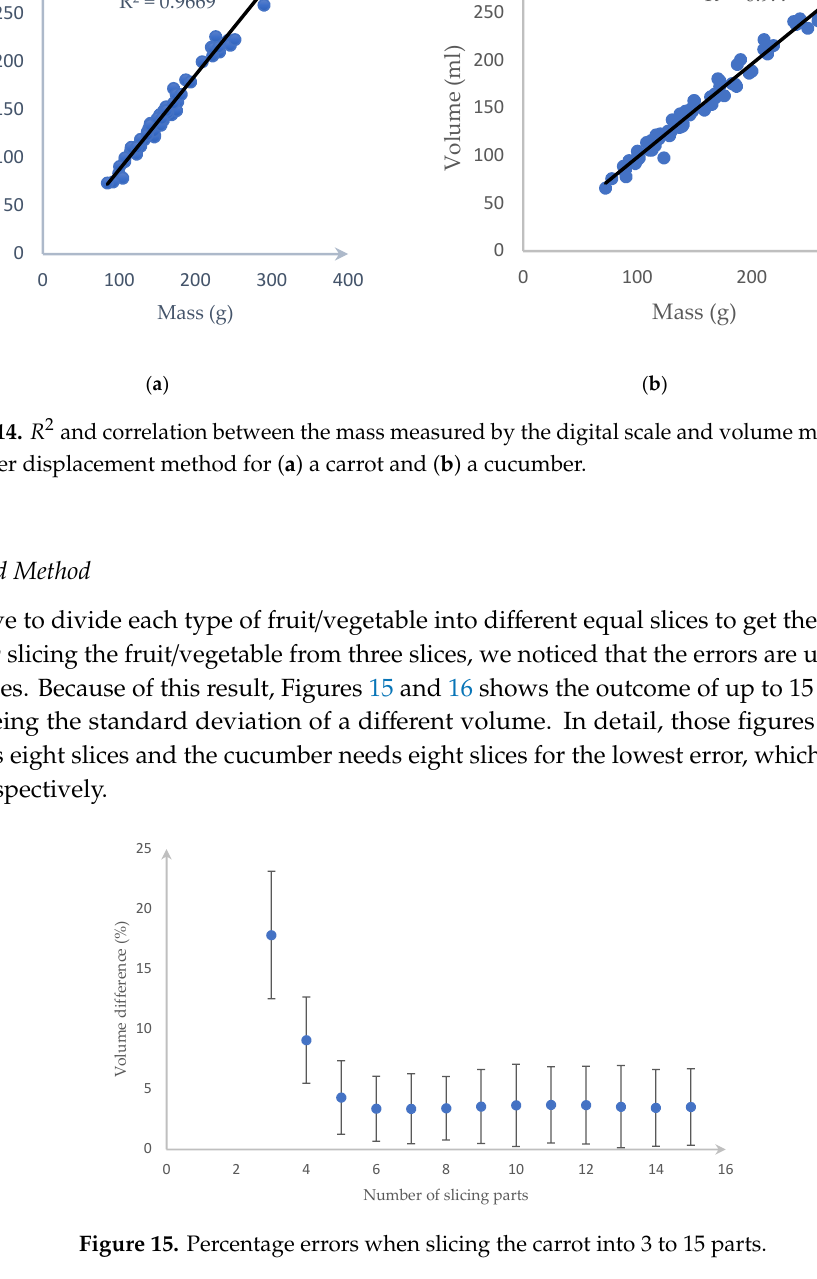
Figure 16. Percentage error when slicing the cucumber into 3 to 15 parts. Over the dataset of 191 carrots and 160 cucumbers, the deviation plot of each fruit/vegetable when applying the proposed method is listed in Figure 17. We can see that almost all the estimated data are in the range of a 95% limit of agreement (outer lines) and the average difference between the two methods is the centerline.